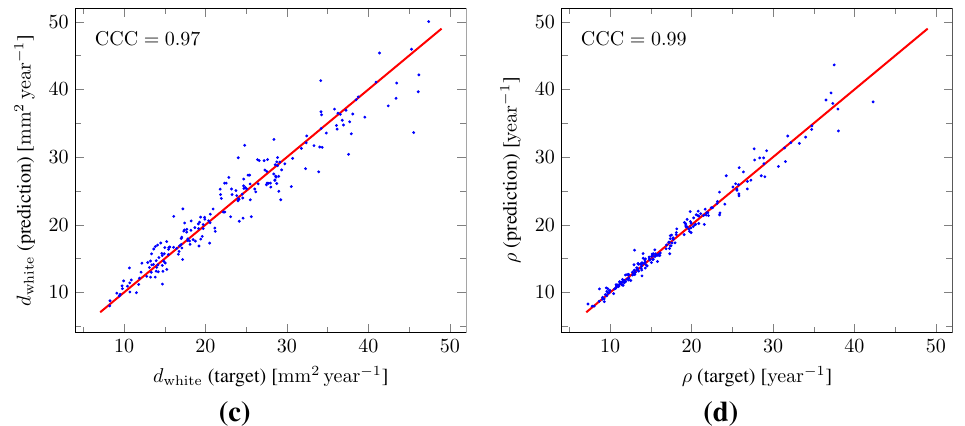
Figure 11. Scatterplots of the true versus predicted values of the model parameters from the test set. ( a , b ) True versus predicted values of λ and v provided by the second network (Figure 6). ( c , d ) True versus estimated values of d white and ρ derived from the predicted values of λ and v using Equations (12) and (13). For each plot, the identity function is superimposed in red and the corresponding Lin’s concordance correlation coefficient (CCC) [47] is provided.